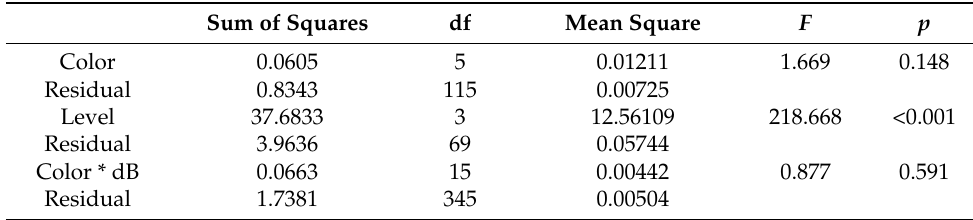
Table 2. ANOVA table (Within Subjects Effects).